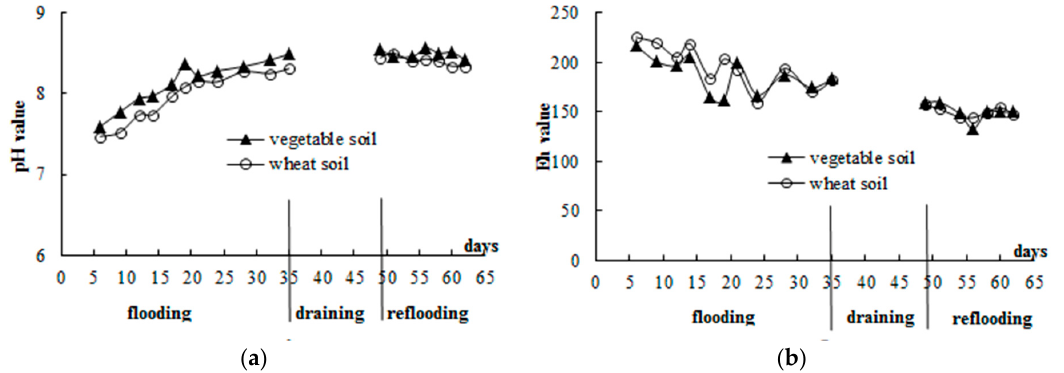
Figure 1. pH and Eh in floodwater (( a ) pH changes; ( b ) Eh changes).